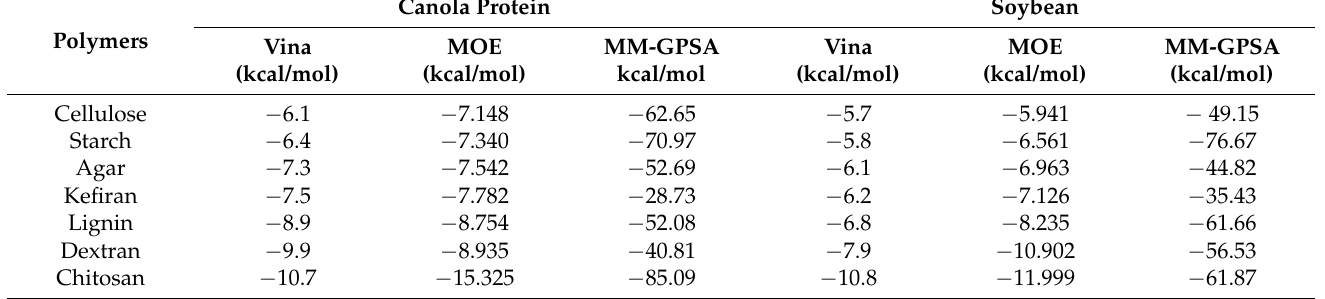
Table 4. Binding energies of protein–binder interactions.